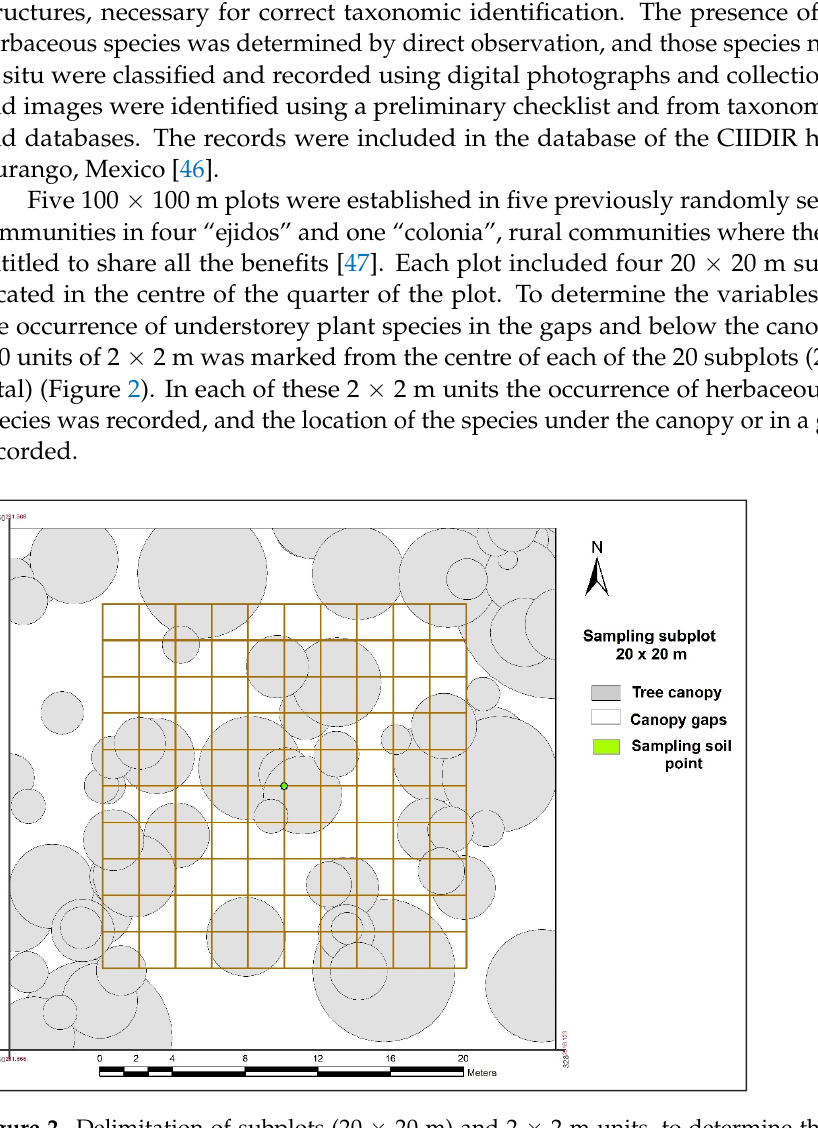
Figure 2. Delimitation of subplots (20 × 20 m) and 2 × 2 m units, to determine the presence of understorey species below the forest canopy and in the gaps.